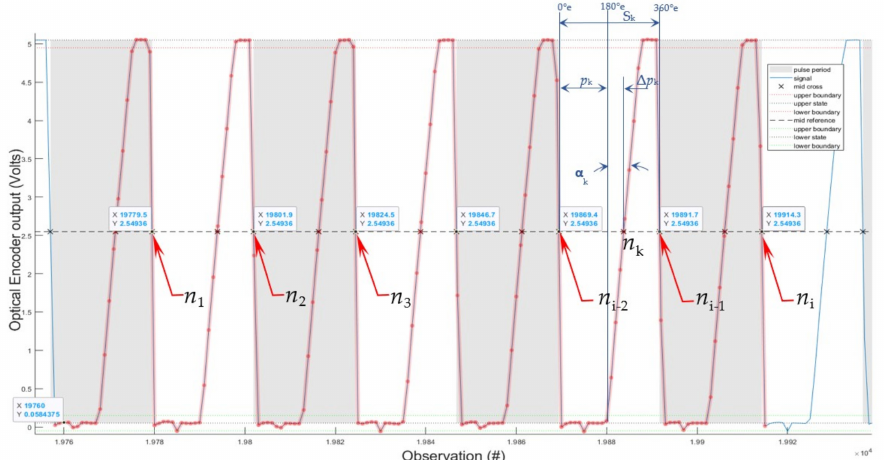
Figure 12. Signal